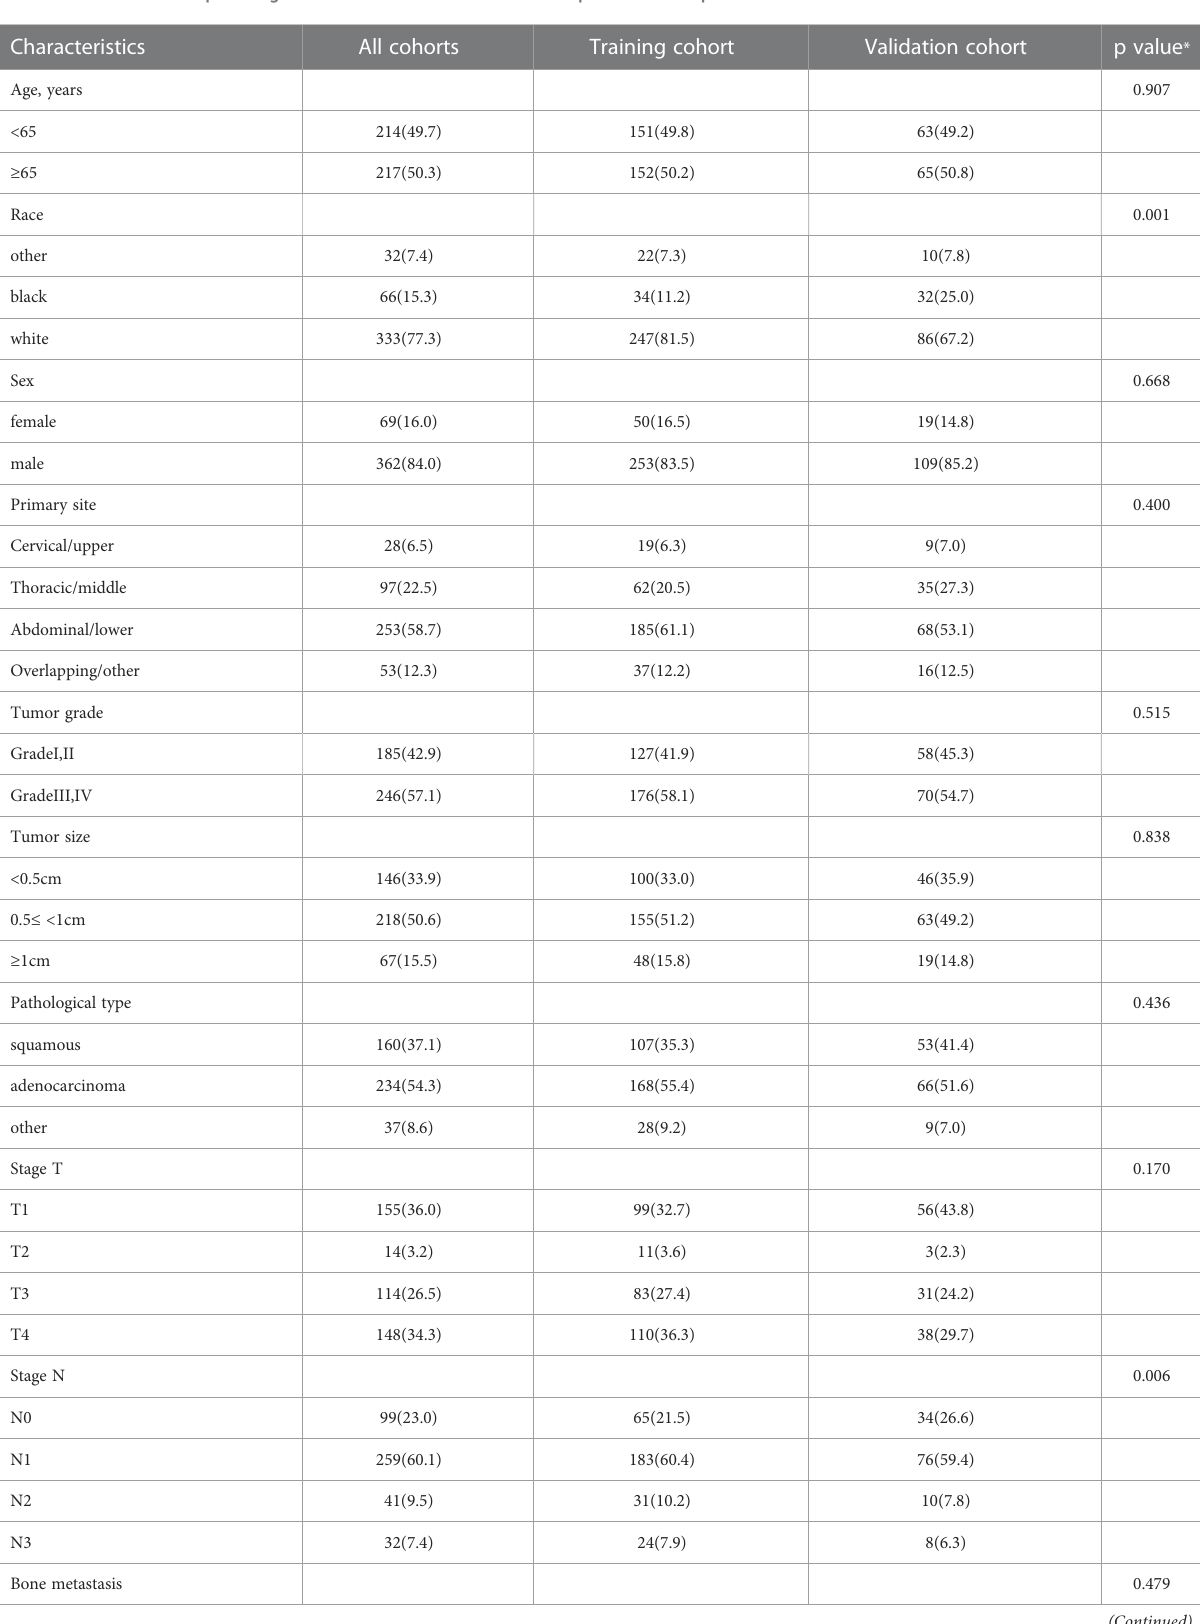
TABLE 1 Baseline clinicopathological characteristics and treatment experience of all